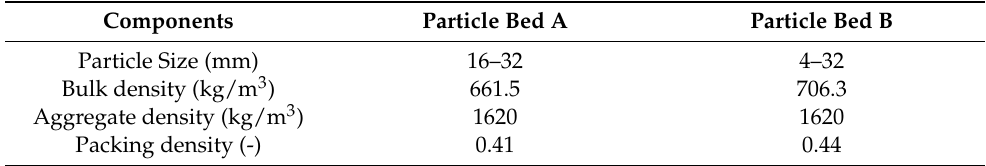
Table 1. Characteristics of the particle